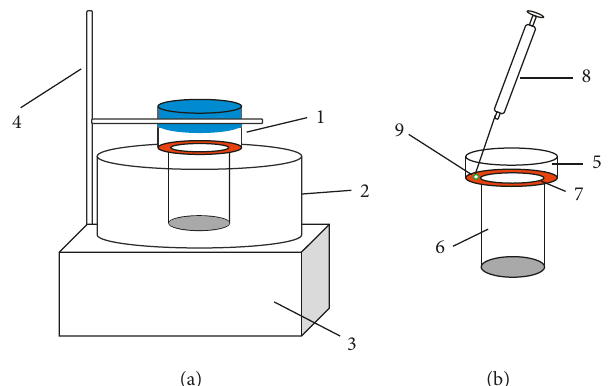
Figure 2: Synthetic routes of the ionic liquid [SBnIM]PF